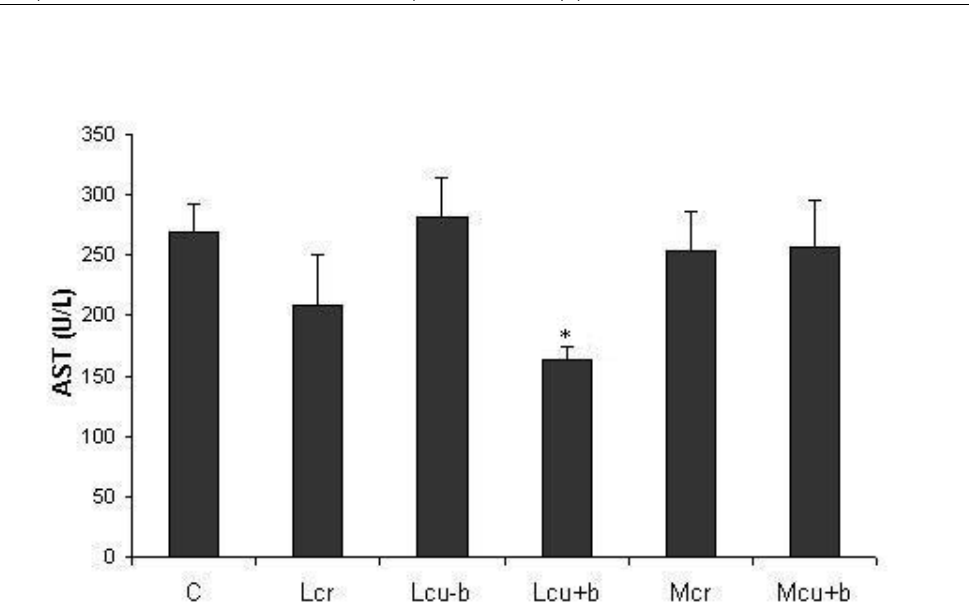
Figure 1. Activity of aspartate aminotransferase [AST (U/L)] in control and treated groups (Lcr, Lcu-b, Lcu+b, Mcr and Mcu+b) after two months of treatment. The values are expressed as mean ± SEM (n = 6). Significant levels observed are * p ≤ 0.05 compared with control group